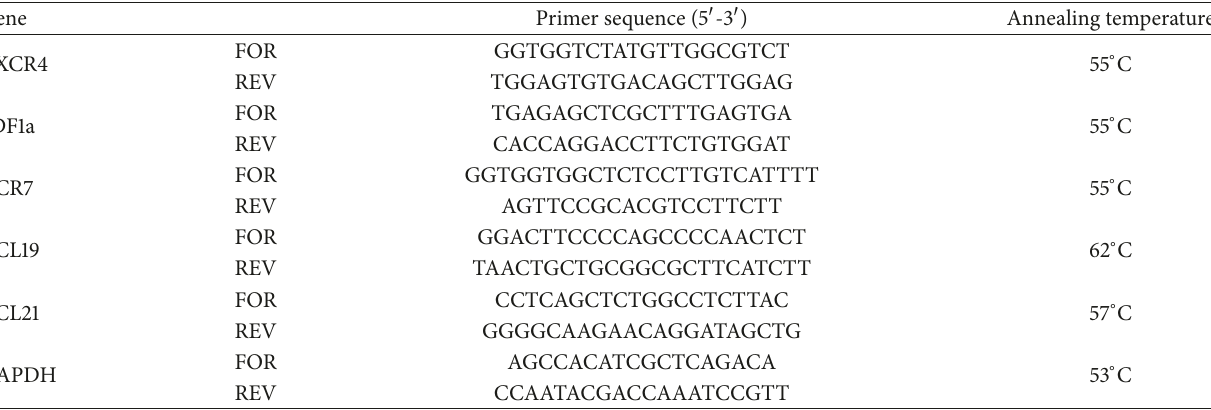
Table 1: Primer sequences used for real-time RT-PCR.